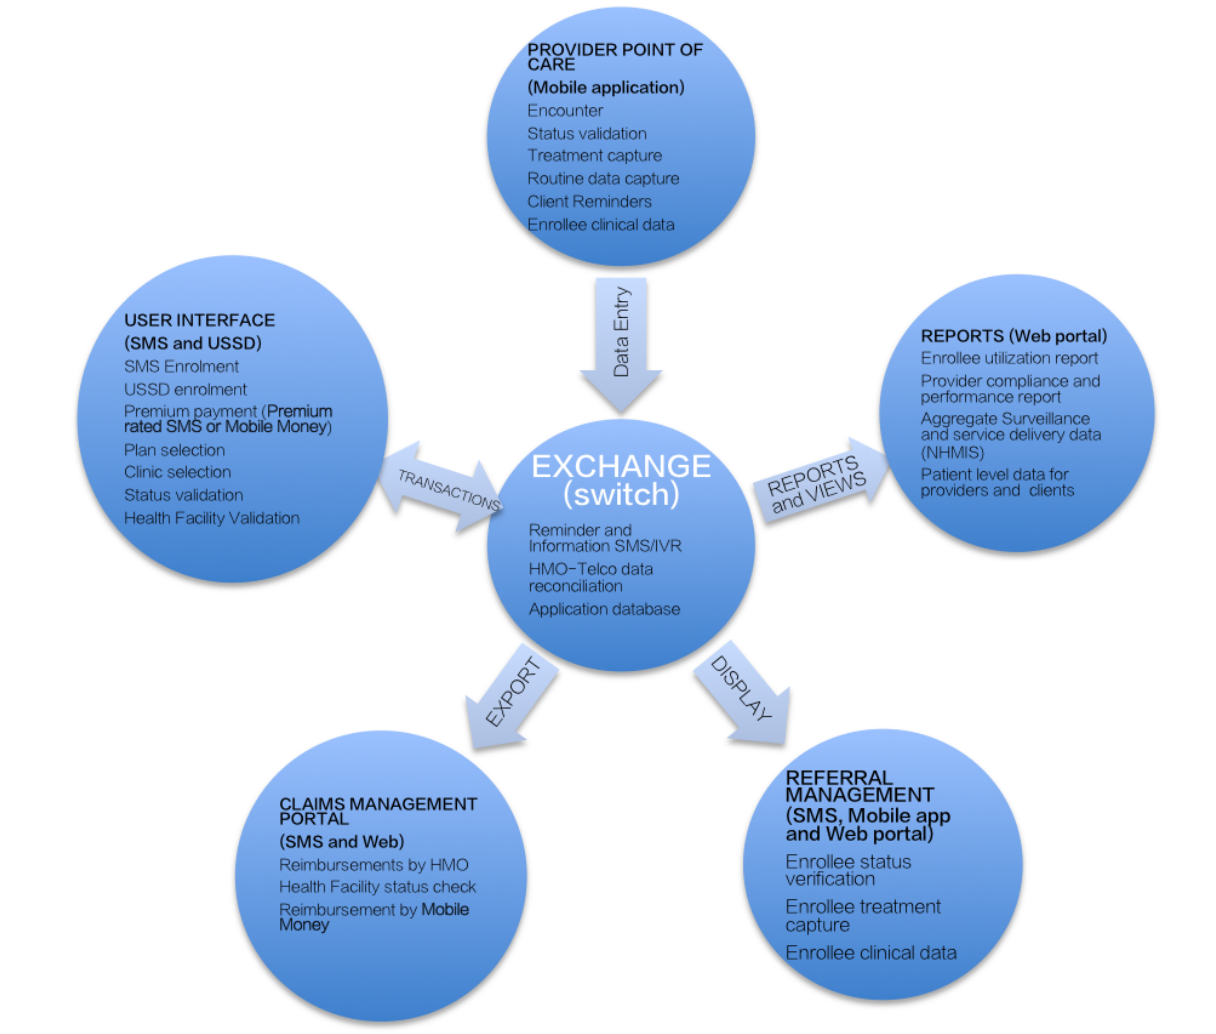
Figure 1. Prototype Software Conceptual